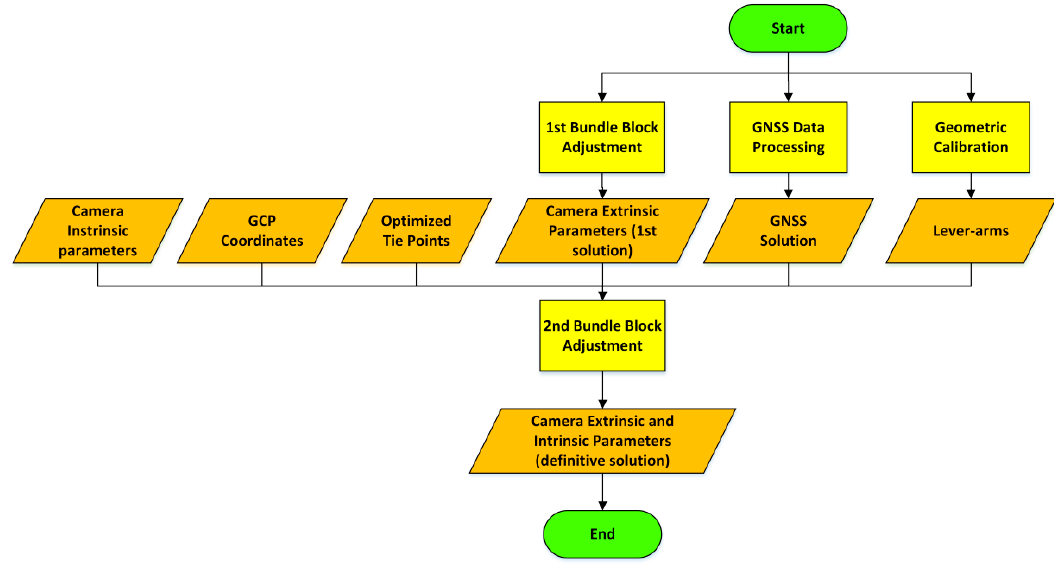
Figure 3. Methodological workflow for the rigorous bundle block adjustment.